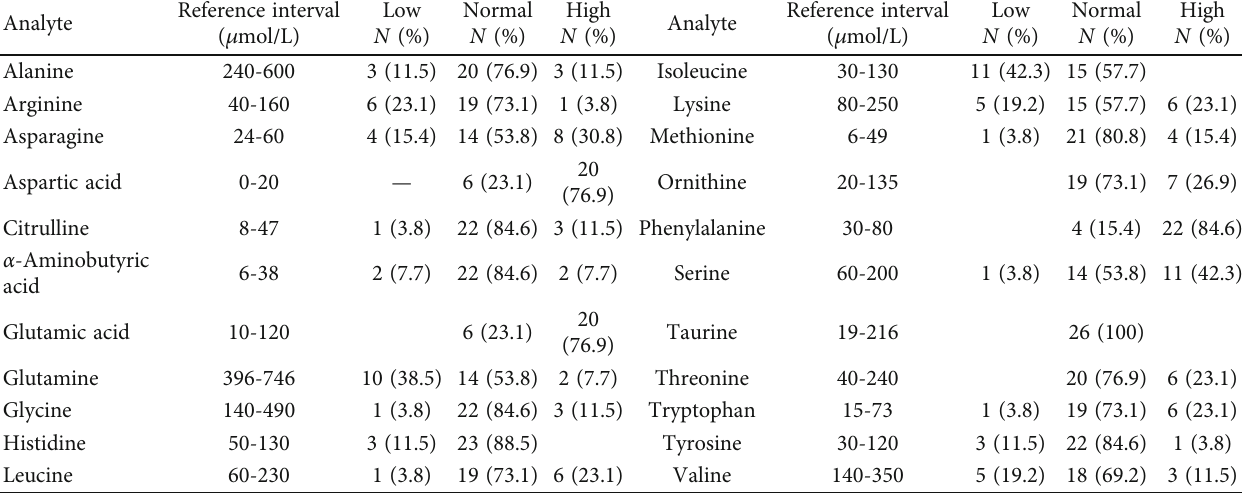
Table 2: Frequency (%) of amino acid abnormality in COVID-19 patients according to the Laboratory Reference Interval. Analyte